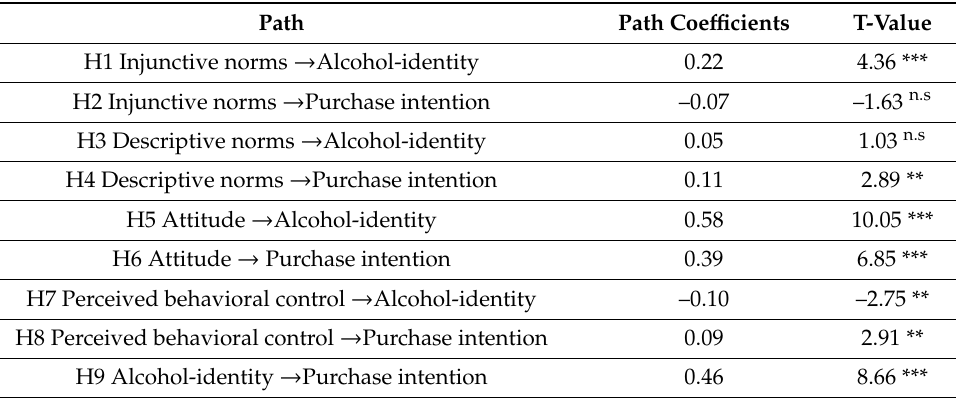
Table 4. Research findings.